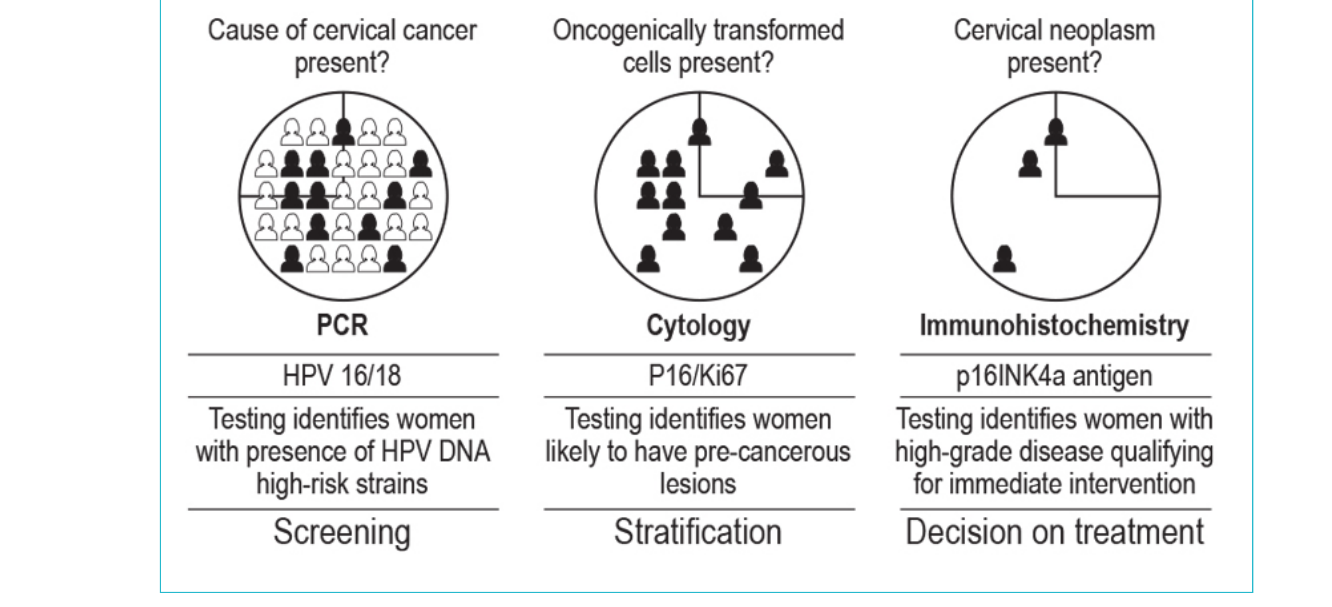
Figure 2: Holistic disease management in the diagnosis of cervical cancer and its associated risk factor of HPV infection.HPV = human papil- lomavirus; PCR = polymerase chain